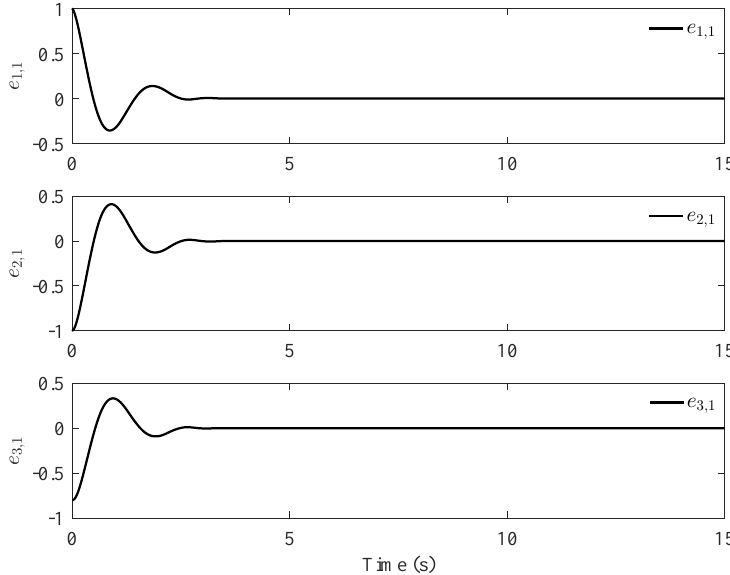
Figure 4. The tracking errors of the position